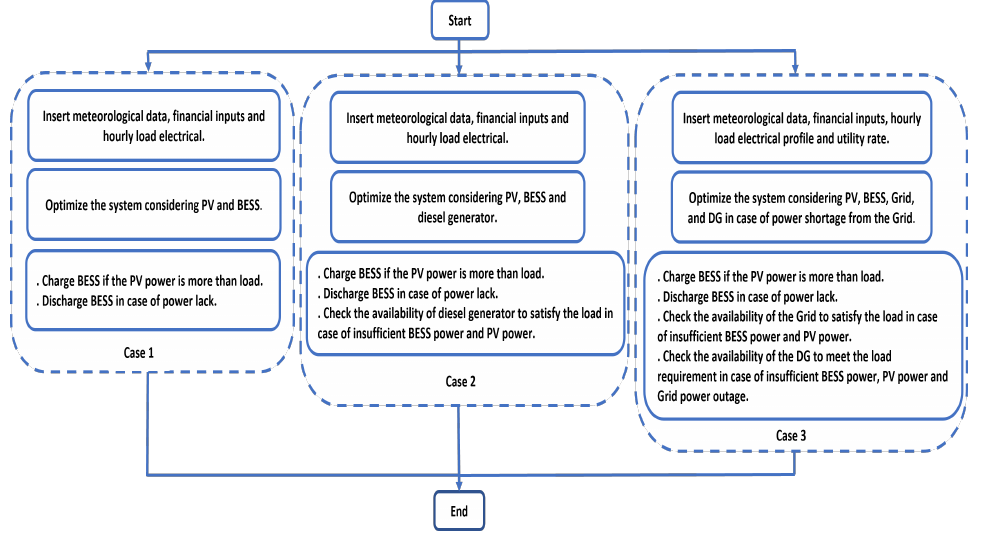
Figure 4. Operating mechanism of each case